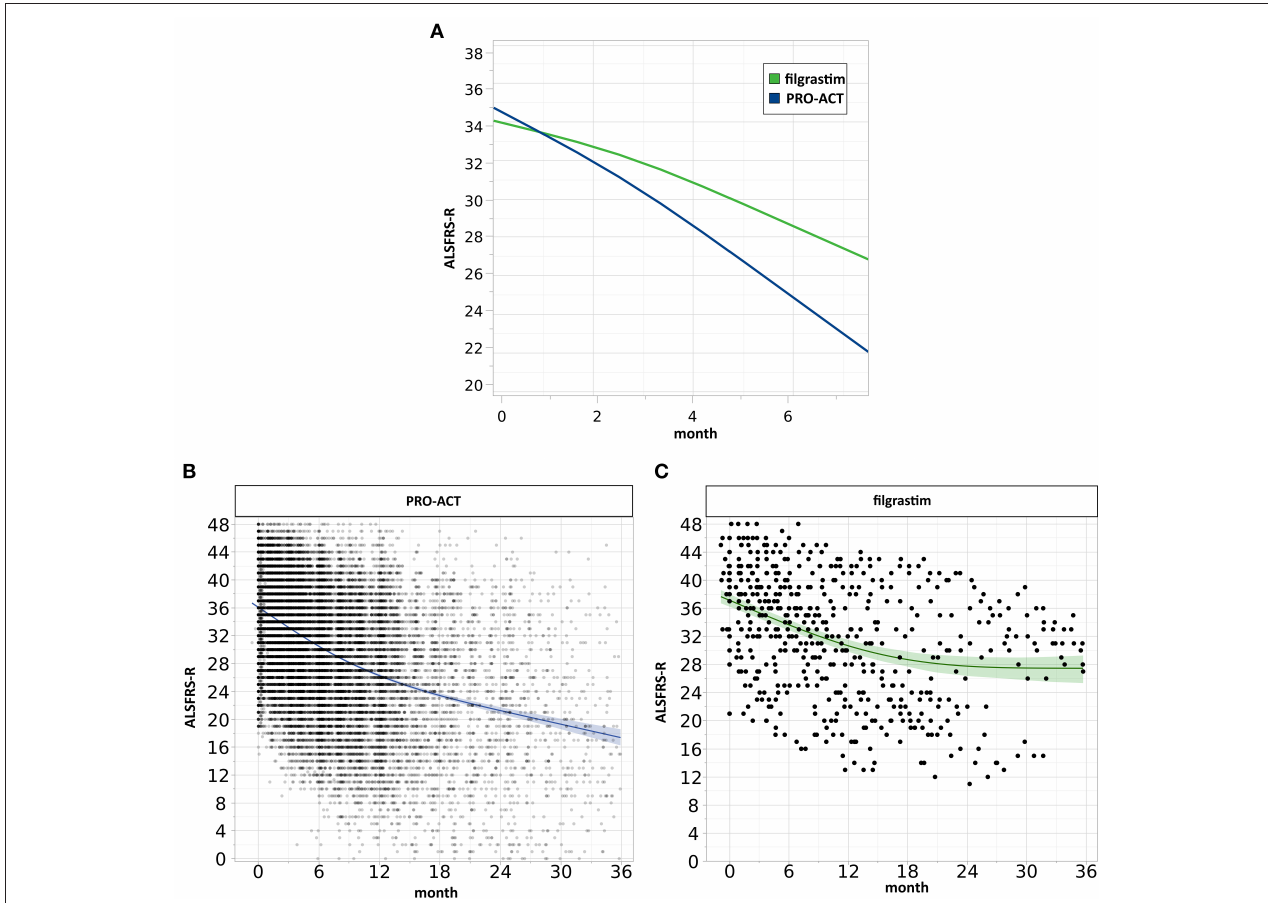
FIGURE 2 | Analysis of clinical progression. (A) Estimated ALSFRS-R courses. The interaction profile of estimated ALSFRS-R score time courses of filgrastim- (green, N = 36) and riluzole-treated PRO-ACT patients from new studies only (blue, N = 6,927) with treatment latency of 10 months includes measurements up to 6 months. The model-estimated decline in filgrastim-treated patients was flatter (interaction term p = 0.0002), and the estimated difference between filgrastim and PRO-ACT after 6 months was 3.7 ALSFRS-R score points. (B,C) Visualization of individual ALSFRS-R data points over 36 months. Individual ALSFRS-R scores (dots) over 36 months. (B) (blue): N = 6,927 riluzole receiving PRO-ACT patients, (C) (green): N = 36 filgrastim-treated patients. Individual data points and smoothing splines visualized the ALSFRS-R scores with 95% CIs. Filgrastim patients stabilize at around 28 ALSFRS-R points; however, already here 2 populations are recognizable. PRO-ACT patients stabilize at around 17 ALSFRS-R